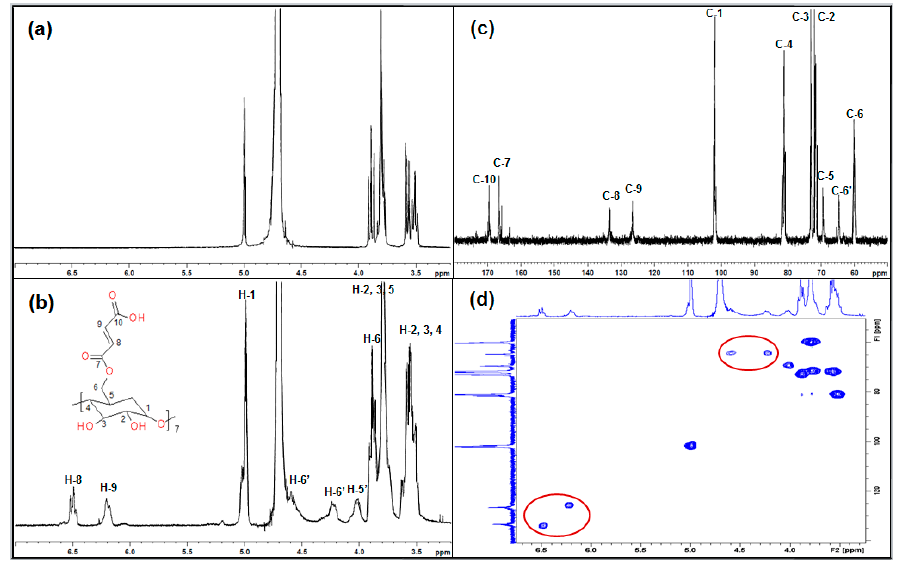
Figure 3. 1 NMR spectra of β -CD in D 2 O ( a ); NMR spectra of MAH- β -CD in D 2 O. 1 H spectrum ( b ); 13 C spectrum ( c ); 2D HSQC 13 C– 1 H plot ( d